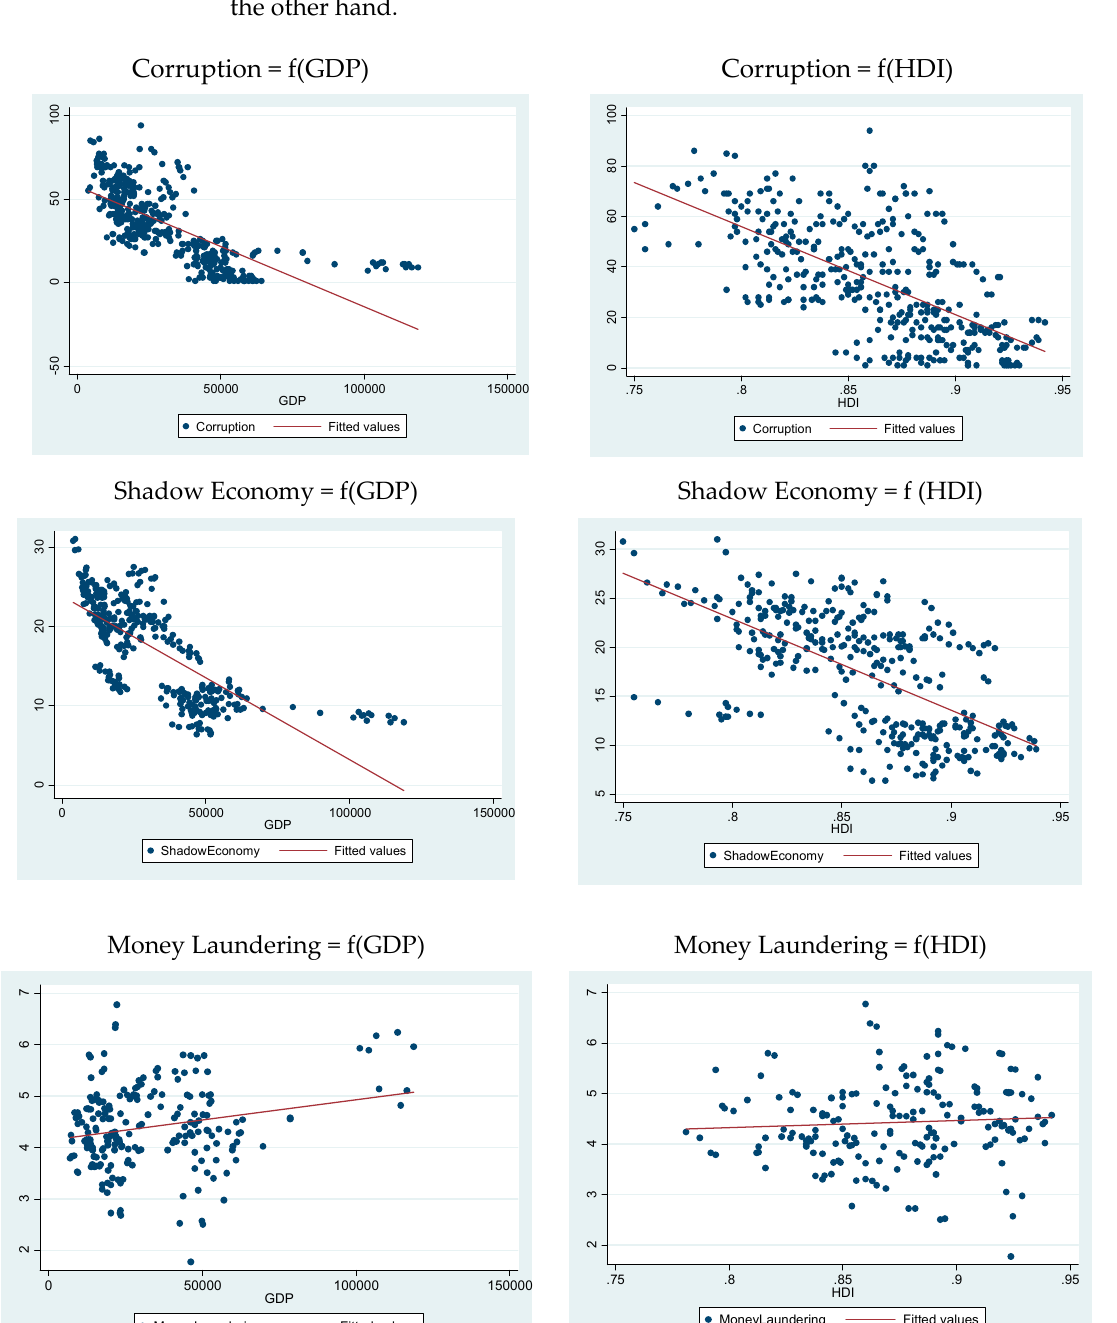
Figure 7. Financial and economic crime proxies as a function of economic and sustainable development. Source: Authors’ procedure in Stata. 4.1. Main Results The results have been synthesized within Table 1. Table 1a contains the estimations of fi- nancial and economic crime proxies as a function of GDP as an economic prosperity proxy: the dependent variables are, in turn, corruption in Model (1a), shadow economy in Model (2a), money laundering in Model (3a), and cybercrime in Model (4a). In the same manner, Table 1b contains the estimations of financial and economic crime proxies (Models (1b)–(4b)) as a func- tion of HDI. Log-log modeling is used, except for Models (3a) and (3b), which are linear-log models. As such, Models (1a), (2a), (4a), (1b), (2b), and (4b) are commonly referred to as elastic